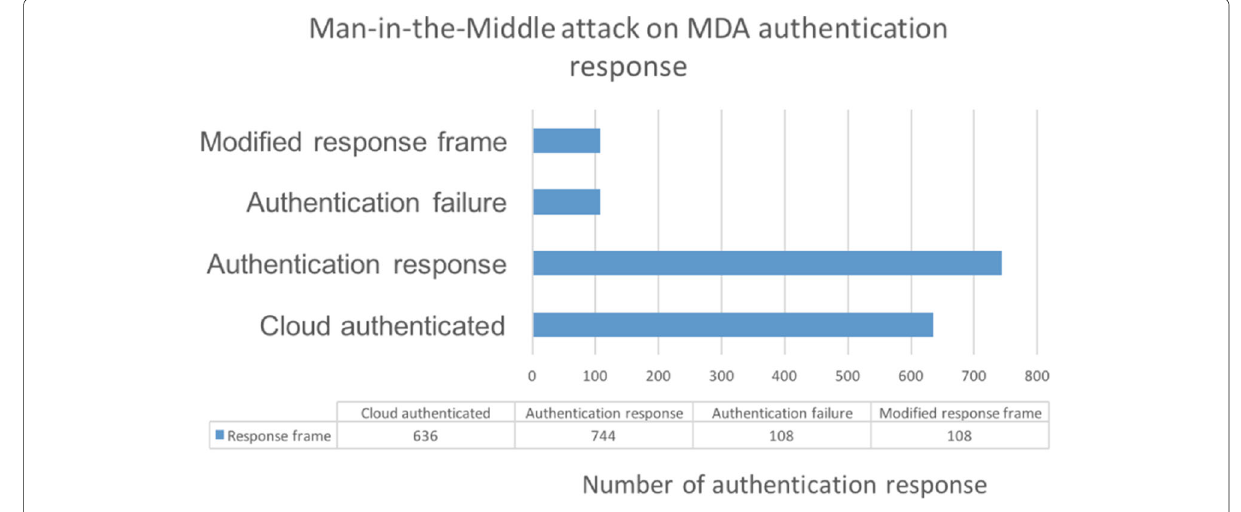
Fig. 6 Man-in-the-middle attack on MDA authentication response